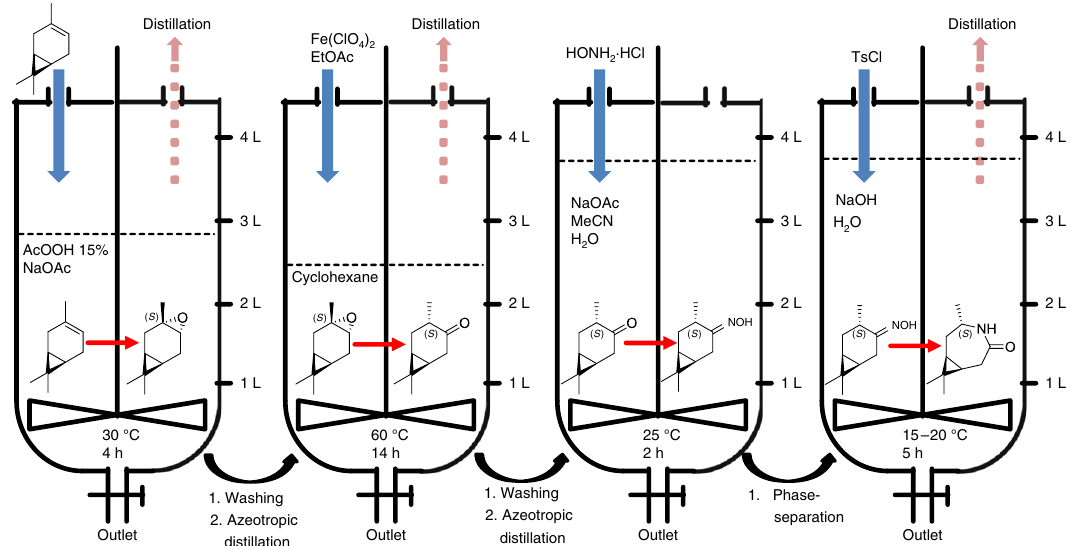
Fig. 2 Up-scale of 5-3S. Schematic one-vessel reaction cascade in a 4.0 L scale for the synthesis of lactam 5-3S . (1) Addition of 1 to the epoxidation reagent AcOOH, washing, addition of cyclohexane and subsequent azeotropic distillation; (2) Meinwald rearrangement of 2-3S to 3-3S with Fe(ClO 4 ) 2 , washing, and solvent exchange to MeCN; (3) oximation to 4-3S using a buffered solution of HONH 2 ·HCl; and (4) Beckmann rearrangement to 5-3S in basic media with tosyl chloride